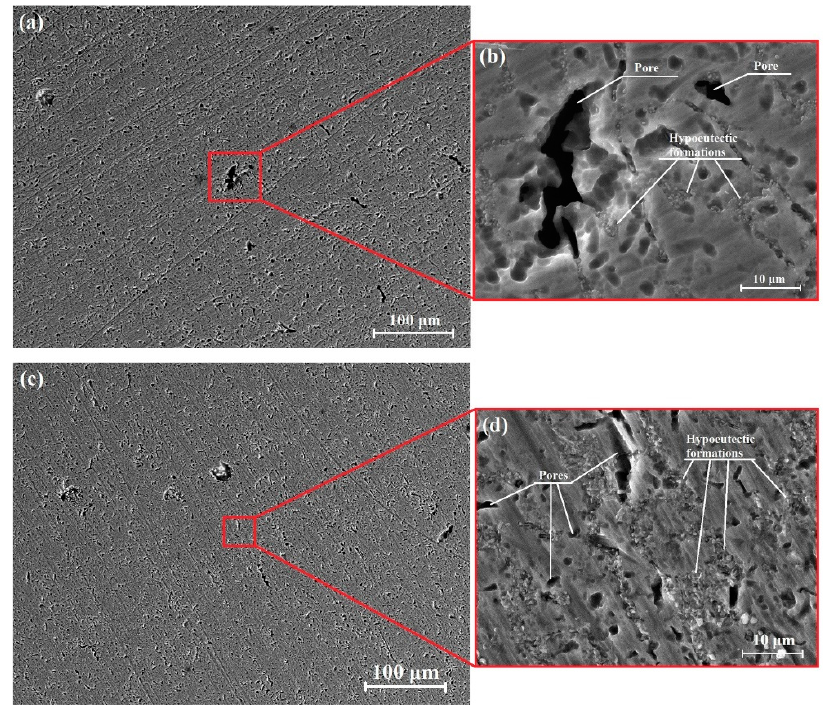
Figure 4. Cross-sectional SEM micrographs of the specimen built at a welding speed of 20.0 mm/s: larger scale micrographs of samples T ( a ) and M2 ( c ) taken in the BSE mode, and closer studied areas of both samples ( b , d ) taken in the SE mode.